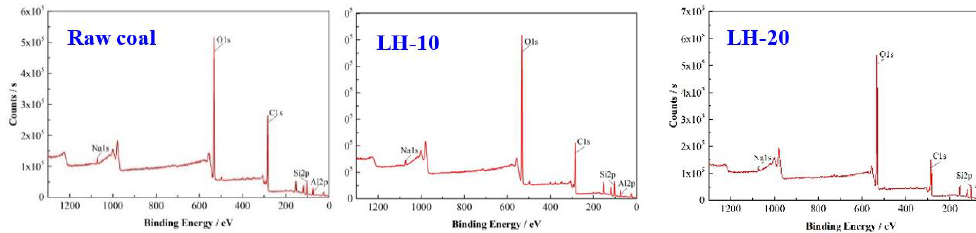
Figure 7. XPS wide energy spectrums of coal before and after heating oxidation at 200 °C.